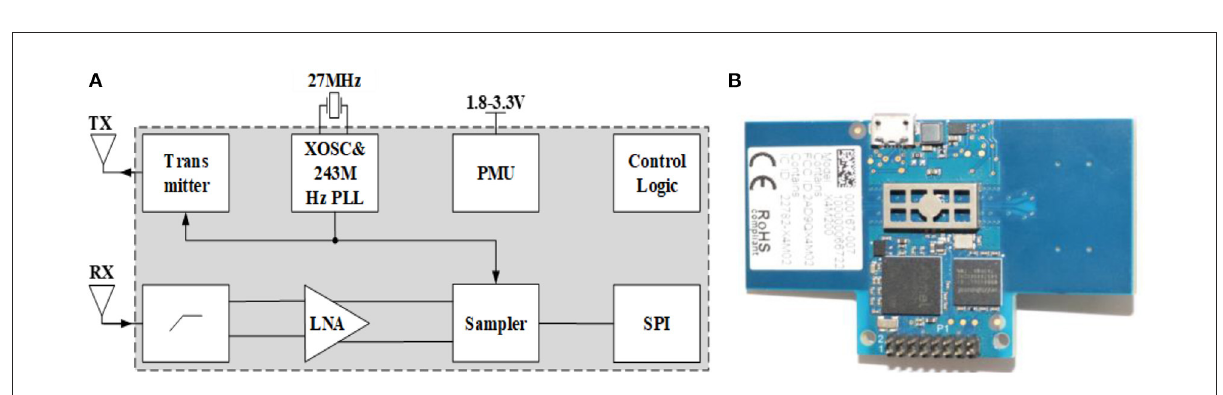
FIGURE5 (A) Radar structure diagram and (B) radar object diagram.